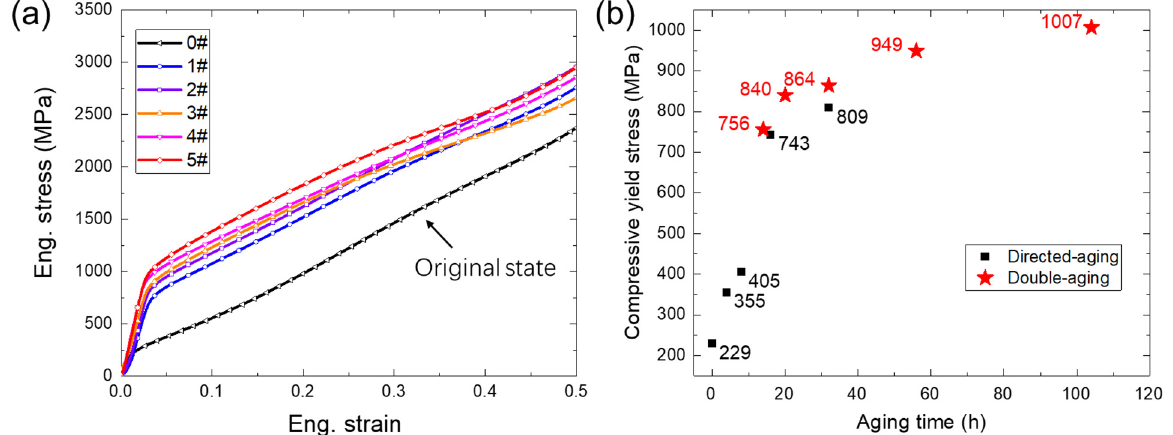
Figure 4. Engineering stress–strain curves of the 945A Ni-based alloys: ( a ) compressive stress–strain curves, ( b ) the compressive yield stress of the presented samples and the previous study of directed aging treatment, data from Ref. [21].